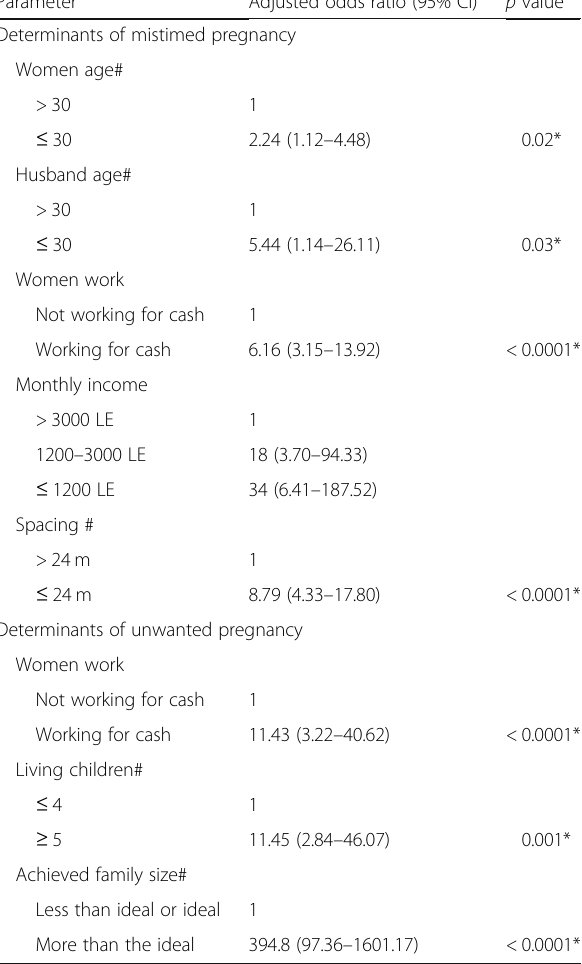
Table 3 Results of the final model of logistic regression analysis of determinants of missed and unwanted pregnancy in women of reproductive age, Sohag, Egypt,